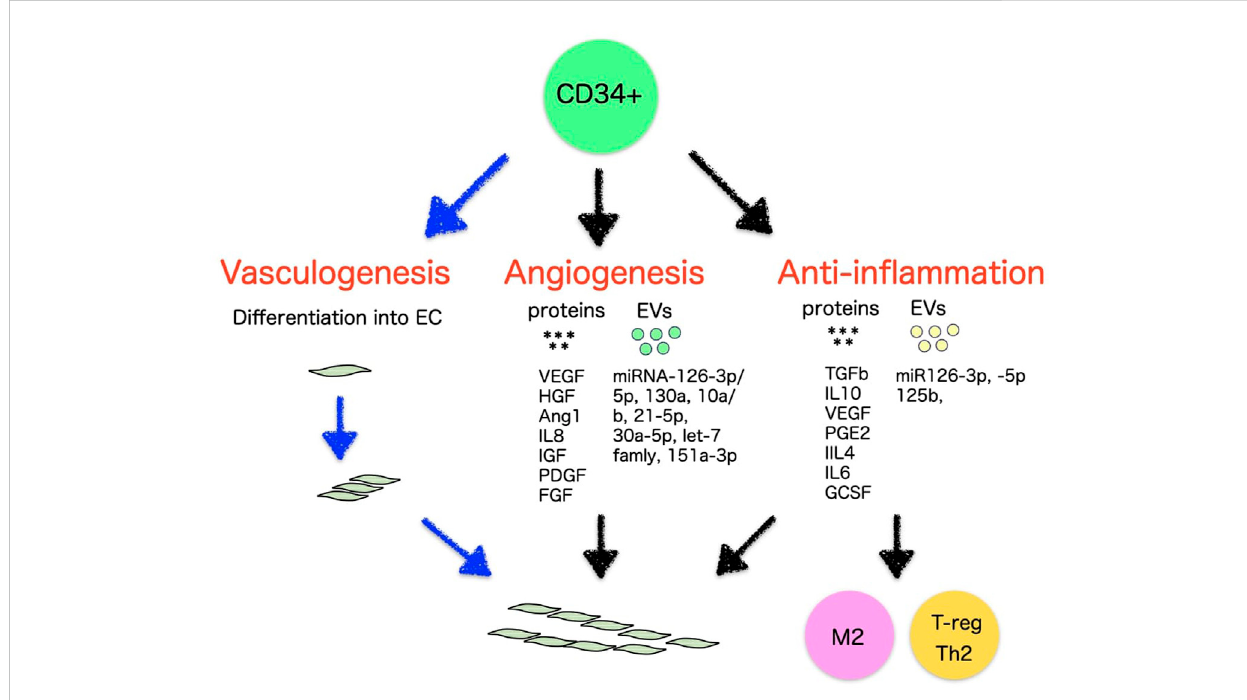
FIGURE 2 Vasculogenic, angiogenic, and anti-in fl ammatory mechanisms of CD34 + cells.